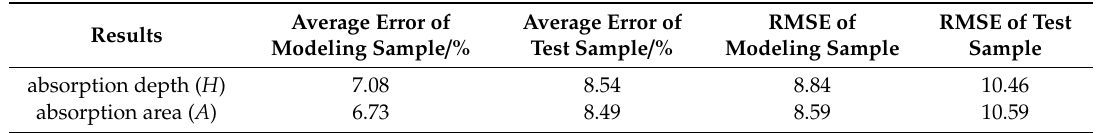
Table 5. Prediction results of absorption depth ( H ) and absorption area ( A ).